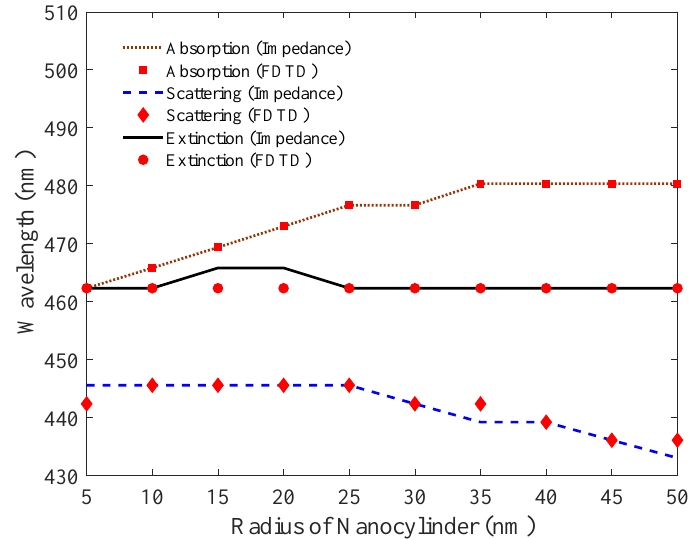
Figure 9. TE n mode extinction, scattering, and absorption cross-sectional areas efficiencies of cylindrical nanowire plotted with change in radius. The proposed model matches well with the full-wave field